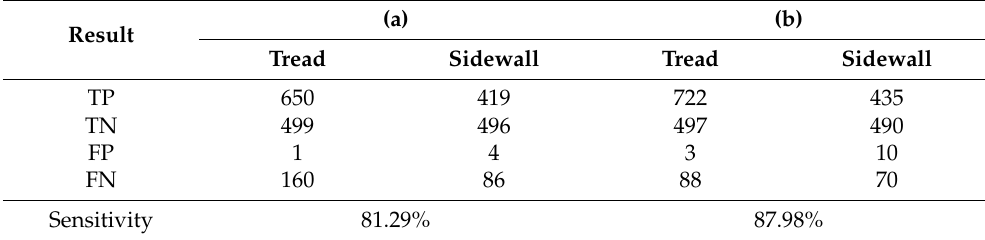
Table 4. Results Obtained by (a) the YOLOv3 Architecture, (b) the Incremental YOLOv3